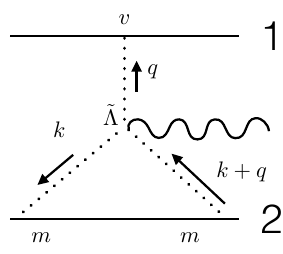
Figure 8 . A diagram with the second \topology" for the leading order radiative correction from 2 the ~ C